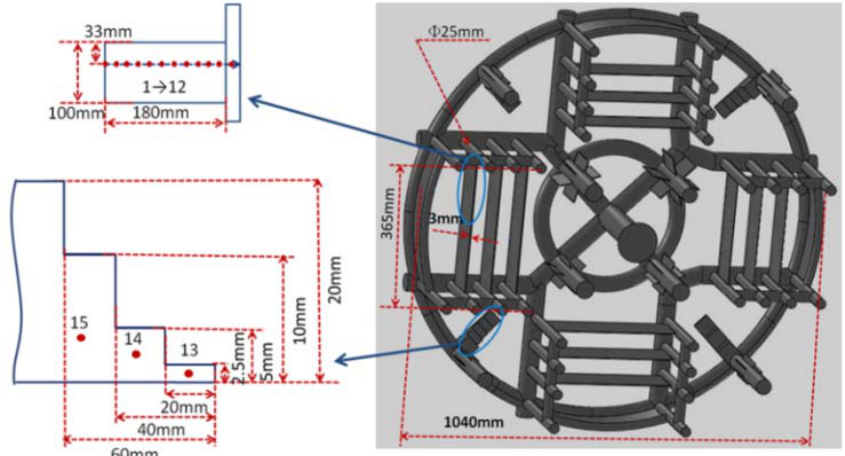
Figure 2. The casting geometry and the sampling positions (Numbers: